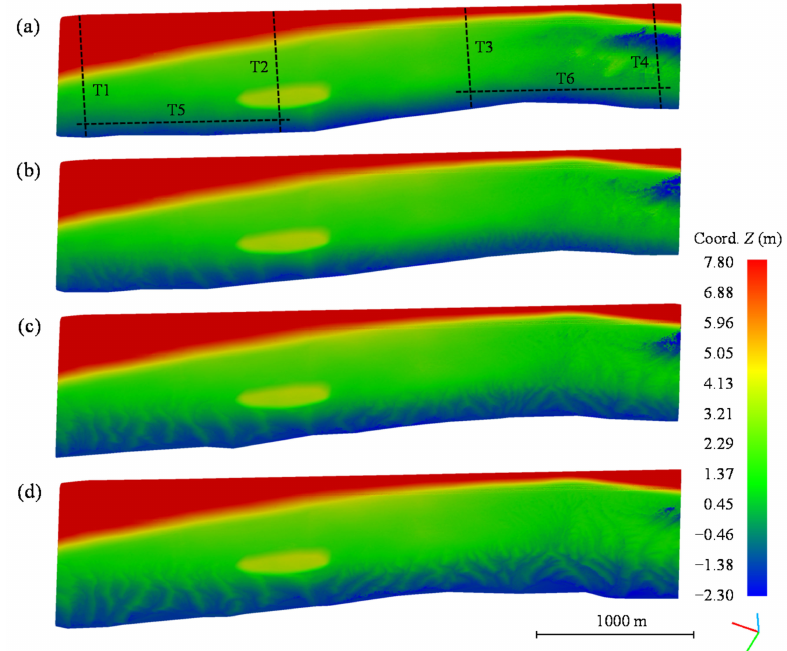
Figure 8. Morphology of the intertidal flats at the time points of ( a ) 0, ( b ) 6, ( c ) 12, and ( d ) 18 months. The positions of the cross-profile transects (T1, T2, T3, T4, T5, and T6), as mentioned later, are marked by dashed lines in Figure 8a. Time = 0 months corresponds to the start of the experiment. The dashed box in Figure 1c marks the observed intertidal flat in the model